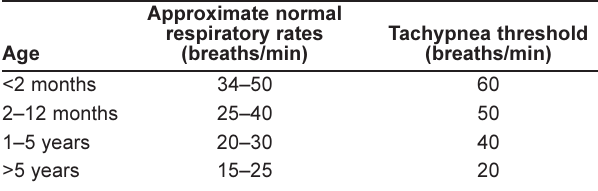
TABLE 1 Age-specific criteria for tachypnea Approximate normal respiratory